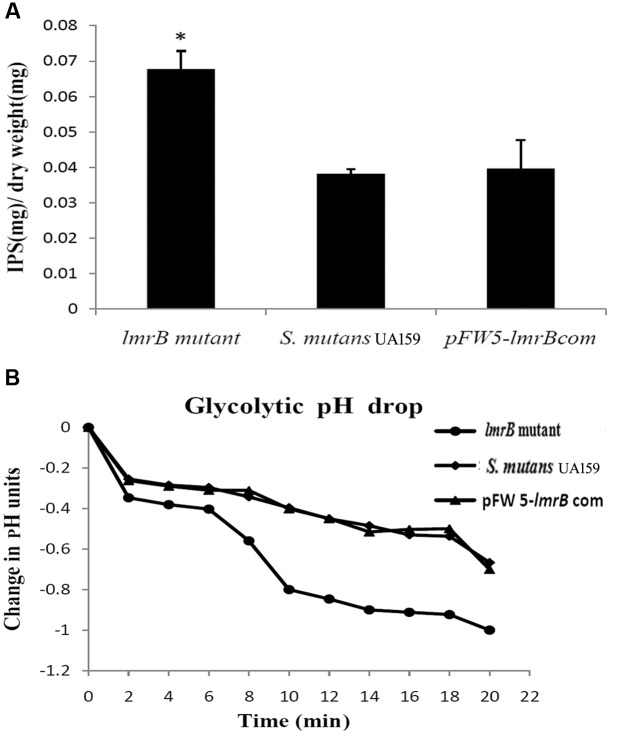
lmrB in S. mutans UA159 was involved in IPS accumulation and glycolytic pH drop. (A) IPS storage in S. mutans UA159 strains. More IPS storage in lmrB mutant was observed compared with the wild type and the complemented strains. ∗Significant difference compared with the wild type (P < 0.05). (B) Glycolytic pH drop of S. mutans UA159 strains in the absence of exogenous glucose. The lmrB mutant was able to reduce the pH to lower values compared with the wild type.